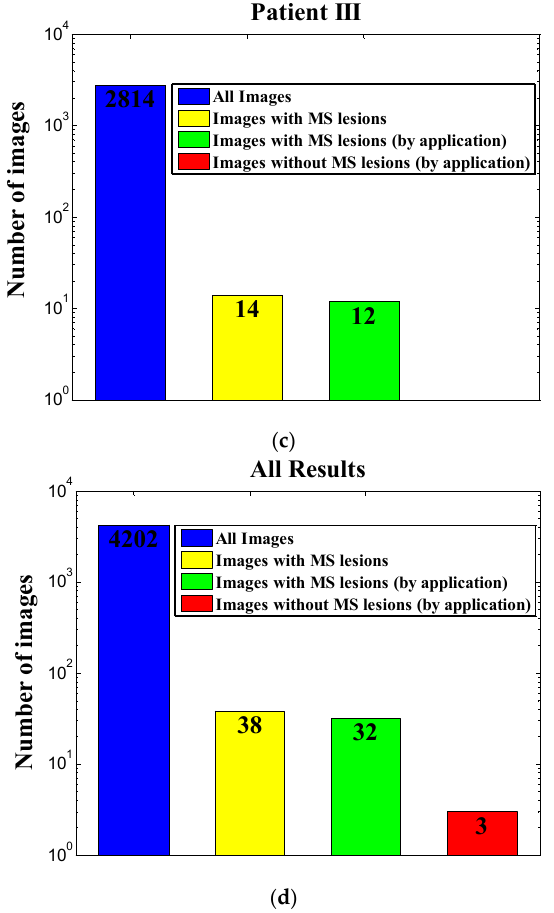
Figure 10. Results: ( a ) patient #1; ( b ) patient #2; ( c ) patient #3; ( d ) summary of the results for all patients.